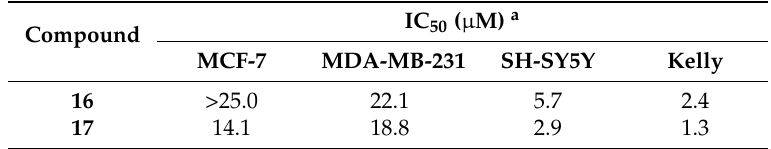
Table 2. IC 50 values of compounds 16 and 17 against four different cancer cell lines.